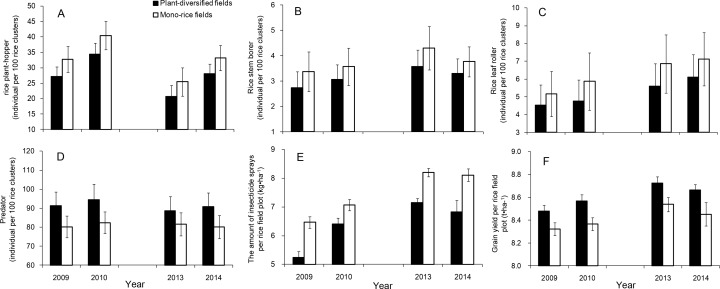
Effects of plant diversification in experiment in which plant-diversified with mono-rice farming were compared at the same locations.(A) Density of rice plant-hoppers sampled in rice field plots; (B) Density of rice stem borers sampled in rice field plots; (C) Density of rice leaf rollers sampled in rice field plots; (D) Density of the predators (ladybird beetles, lacewings and spiders) sampled in rice field plots; (E) Amount of insecticide sprays per rice field plot (kg•ha−1); and (F) Grain yield per rice field (t•ha−1). Vertical bars denote SE.10.7554/eLife.35103.020Figure 6—source data 1.Stem borer: mean and standard deviation (individual per 100 rice clusters) from the common-location-experiments, stratified by year, farm identity, and farm type.
10.7554/eLife.35103.021Figure 6—source data 2.Rice plant-hopper: mean and standard deviation (individual per 100 rice clusters) from the common-location-experiments, stratified by year, farm identity, and farm type.
10.7554/eLife.35103.022Figure 6—source data 3.Leaf roller: mean and standard deviation (individual per 100 rice clusters) from the common-location-experiments, stratified by year, farm identity, and farm type.
10.7554/eLife.35103.023Figure 6—source data 4.Predator: mean and standard deviation (individual per 100 rice clusters) from the common-location-experiments, stratified by year, farm identity, and farm type.
10.7554/eLife.35103.024Figure 6—source data 5.Insecticide amount: mean and standard deviation (kg•ha−1) from the common-location-experiments, stratified by year, farm identity, and farm type.
10.7554/eLife.35103.025Figure 6—source data 6.Yield: mean and standard deviation (kg•ha−1) from the common-location-experiments, stratified by year, farm identity, and farm type.